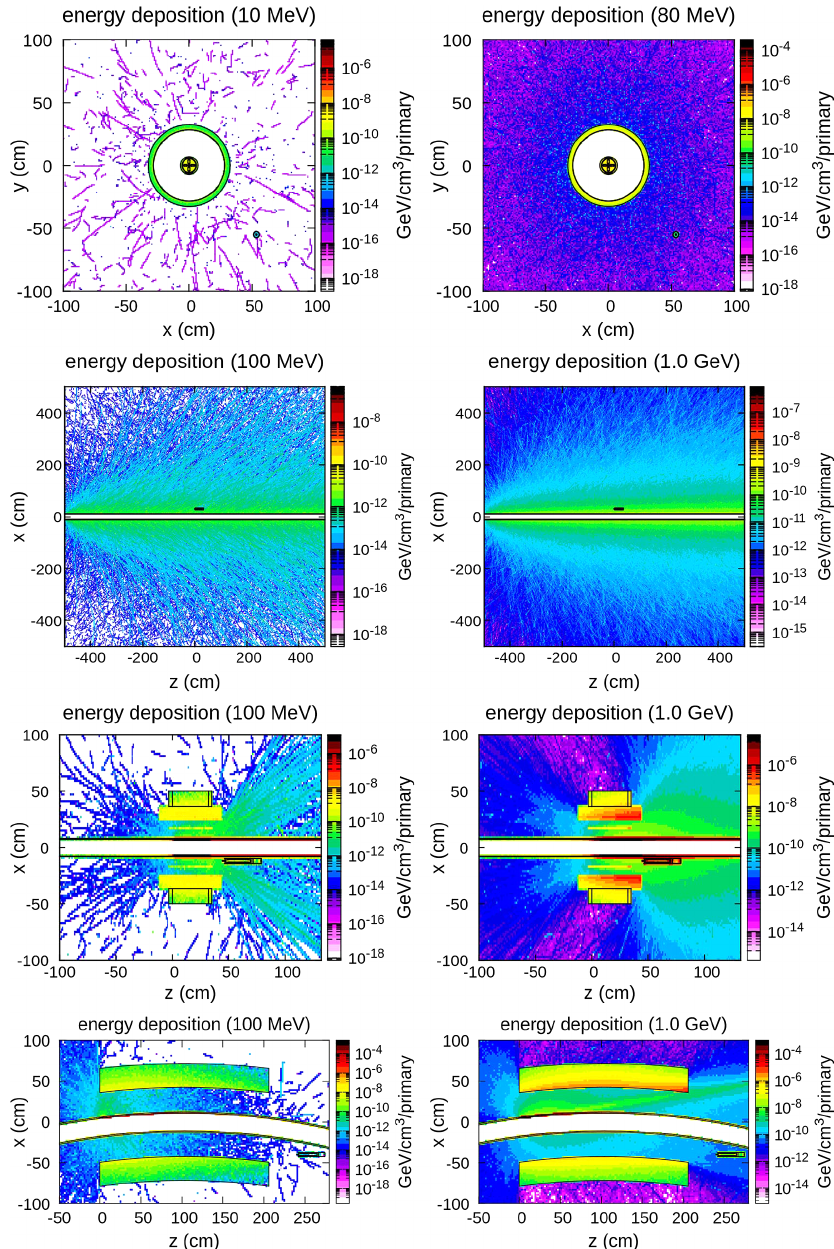
FIG. 19. Energy deposition maps in the XY plane for loss scenario I at the beam energy of 10 and 80 MeV, and maps in the XZ plane at the beam energy of 100 MeVand 1.0 GeV for the beam loss scenarios II, III and VI (from top to bottom row). Maps are averaged over 4 cm, and the white annular region (scenario I) or horizontal strip (scenarios II, III, VI) corresponds to the vacuum region where no energy is